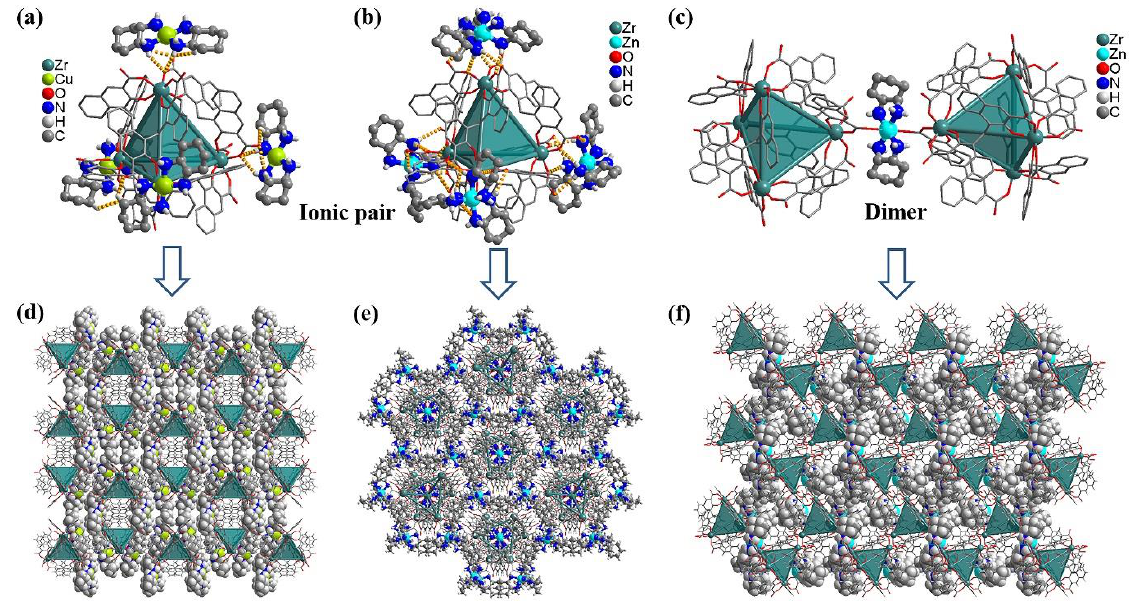
Figure 1. Two cage-based ionic pairs composed of a Zr 4 L 6 cage and different metal-cation units: PTC-355 ( a ) and PTC-356 ( b ). ( c ) The dimer structure of PTC-357 formed by two Zr 4 L 6 cages and one [Zn(cis-DCH)2] 2+ cation. ( d – f ) The 3D packed structures of PTC-355 – PTC-357 , respectively. Atom color code: green, Cu; powder blue, Zn; olive, Zr; red, O; blue, N; gray, C; off white, H. Some H atoms have been removed for clarity.